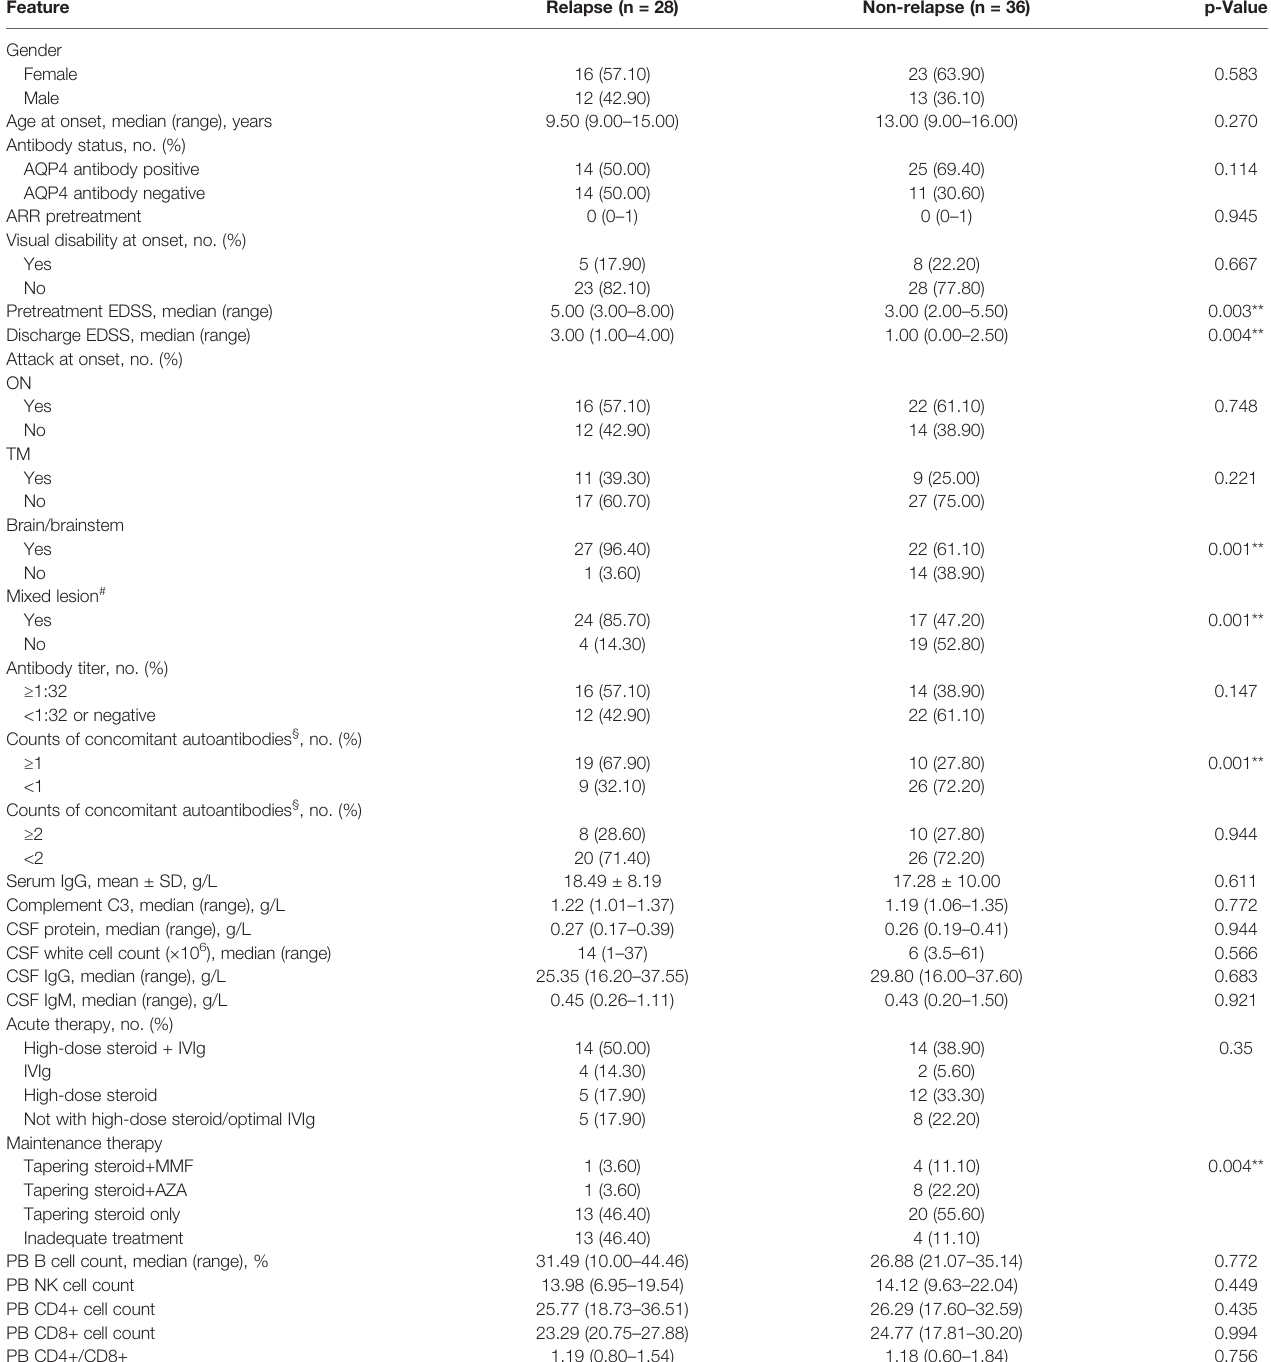
TABLE 2 | Univariate analysis between patients with/without relapse in the primary